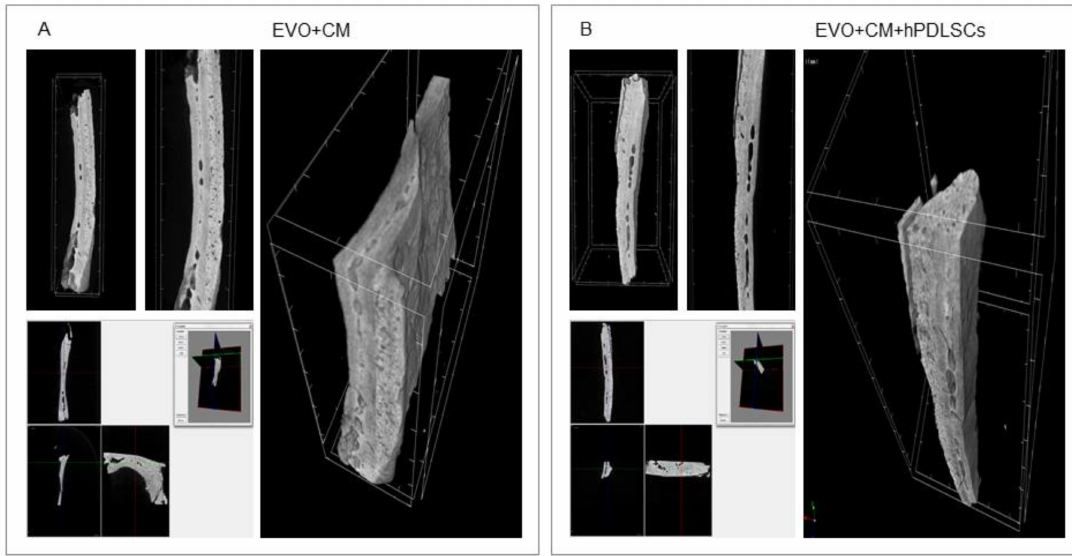
Figure 7. Micro-computed tomography (CT) analyses. 3D volume rendering and 2D virtual sectioning in the 3 orthogonal planes of EVO + CM ( A ) and EVO + CM + hPDLSCs ( B